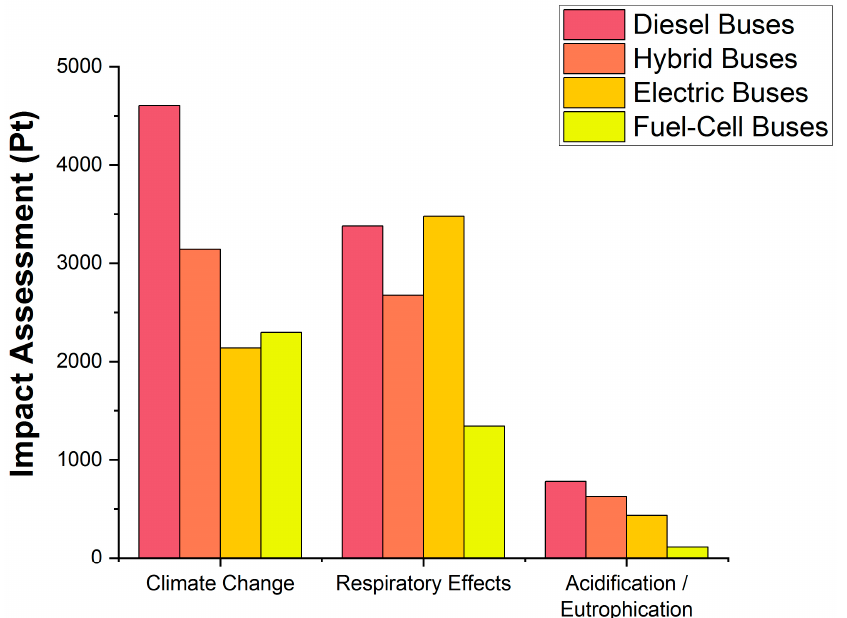
Figure 10. Daily Environmental Impact Assessment of Different Fuel Bus Technologies in Morocco.